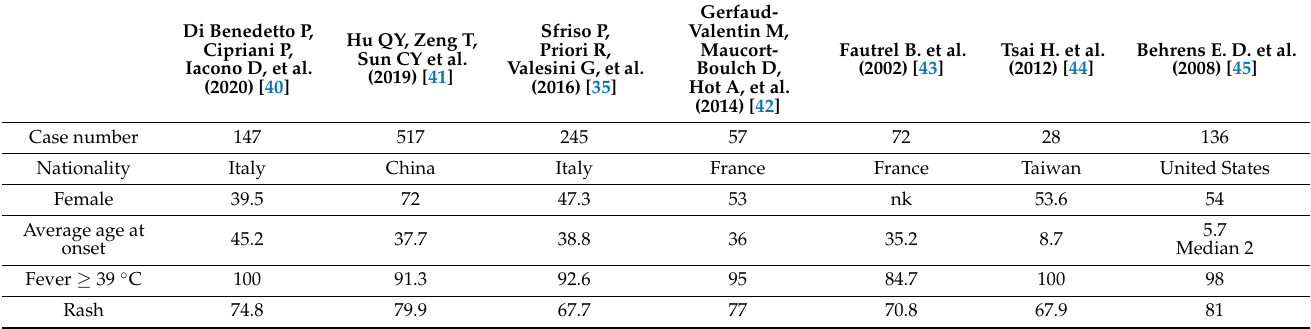
Table 2. Comparison of clinical features (%) of patients with AoSD and